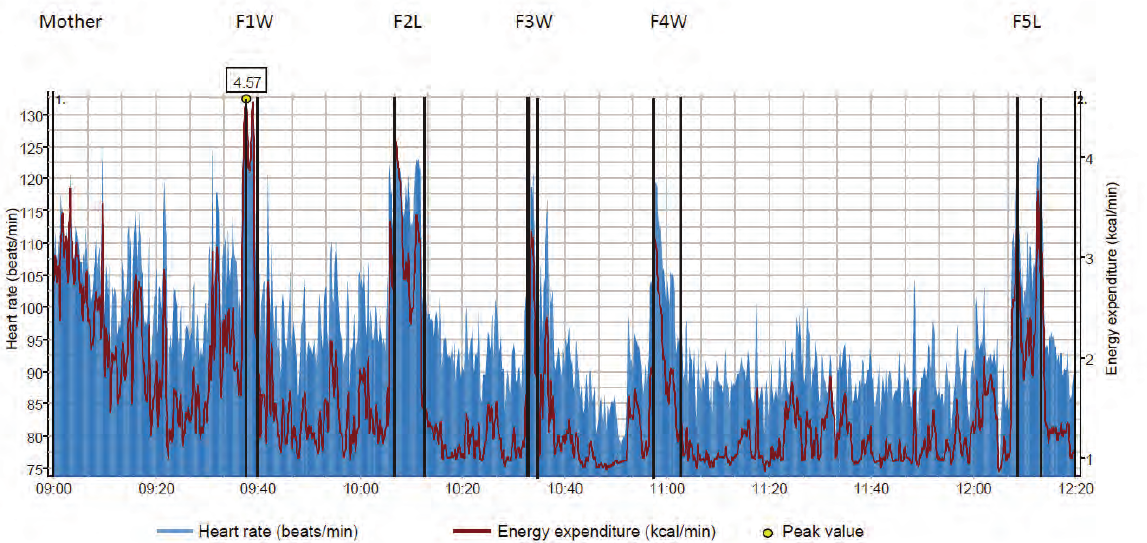
Figure 2. Cardiovascular and energy expenditure patterns of mother immediately before, during, and immediately after watching son